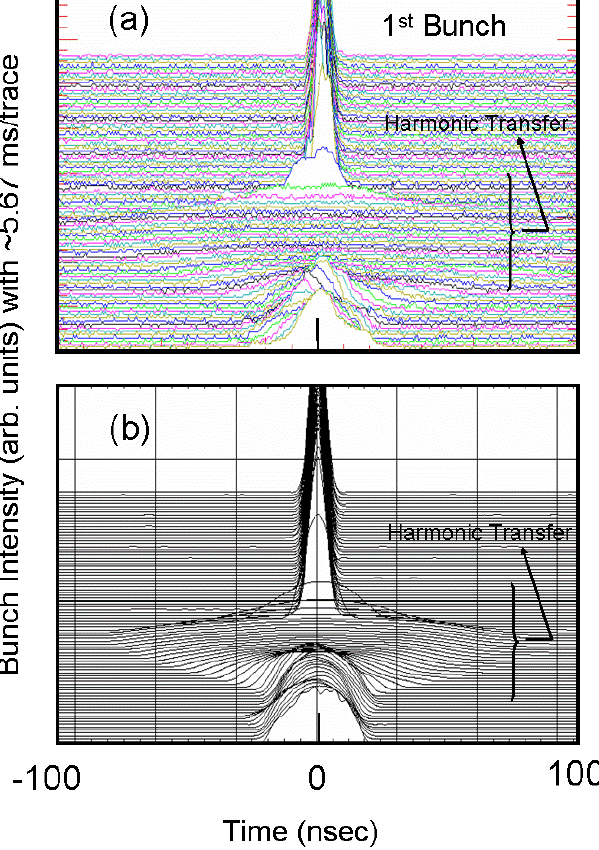
FIG. 7. (Color) Mountain range plots during harmonic transfer from a 2.5 MHz bucket to a 53 MHz bucket at 27 GeV =c for (cid:2) 95% (cid:3) (cid:1) 2 eV s : (a) experimental results 6 (cid:7) 10 10 = bunch and " l and (b) ESME predictions for the first bunch from a train of four bunches. The total time along the vertical axes is about 0.5 sec.